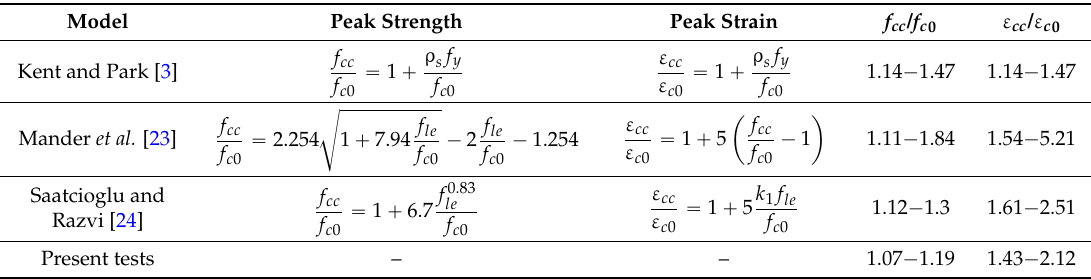
Table 6. Existing models to predict f cc /f c 0 and ε cc / ε c 0